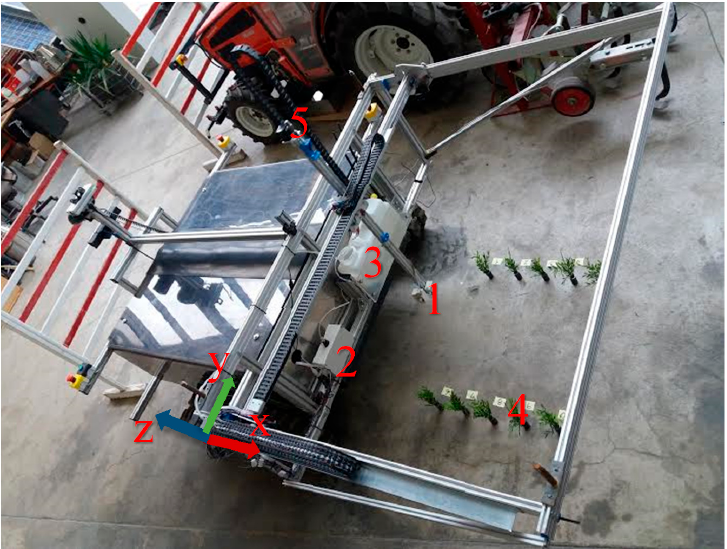
Figure 1. Description of the used automatic spraying system with all the hardware components mounted (1. Tool center point; 2. Control unit and motor controllers; 3. Water tank; 4. Plants; 5. Calibration point).